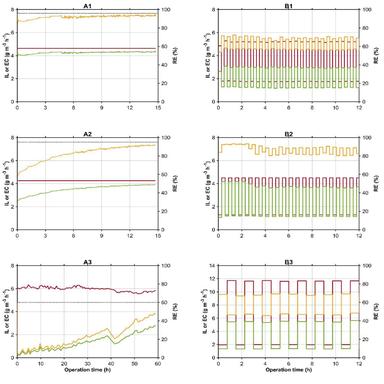
(A1) Evolution of IL, EC and RE after a one day starvation period. RE0 represents the RE of the day before the starvation period. (A2) Evolution after a five days starvation period. (A3) Evolution after a 10 days starvation period. After 37 h, leachate recirculation from top of the BF was performed. (B1) Square wave (15 min interval) of the IL between 1.7 and 5.2 g m3 h1 (on day 114 of operation) with a pre-adaptation at IL of 1.7 g m3 h1 . (B2) Square wave (15 min interval) of the IL between 1.3 and 4.5 g